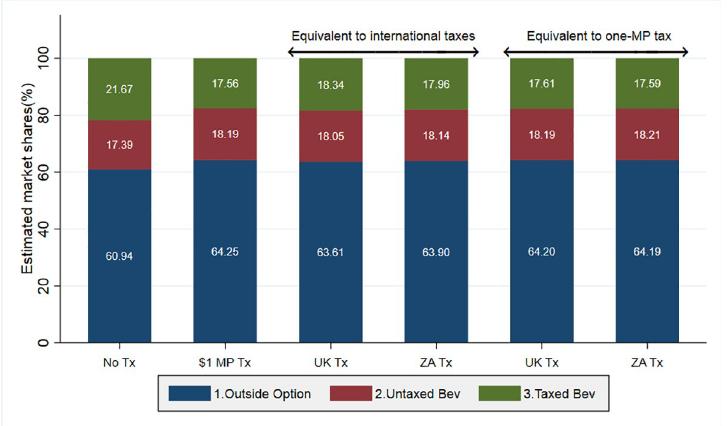
Fig 4. Estimated market share by beverage type and tax design. MP: Mexican peso. UK: United Kingdom. ZA: South Africa. Source : Authors’ own analyses and calculations based on data from Nielsen through its Mexico Consumer Panel Service (CPS) for the food and beverage categories for January 2012 –December 2015. The Nielsen Company, 2016. Nielsen is not responsible for and had no role in preparing the results reported herein.